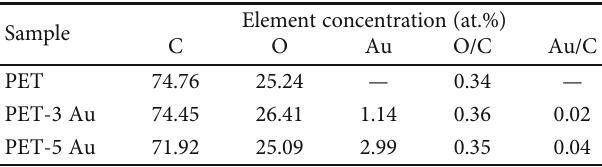
Table 2: Element concentrations of C, O, and Au from XPS measurements. Element concentration Sample